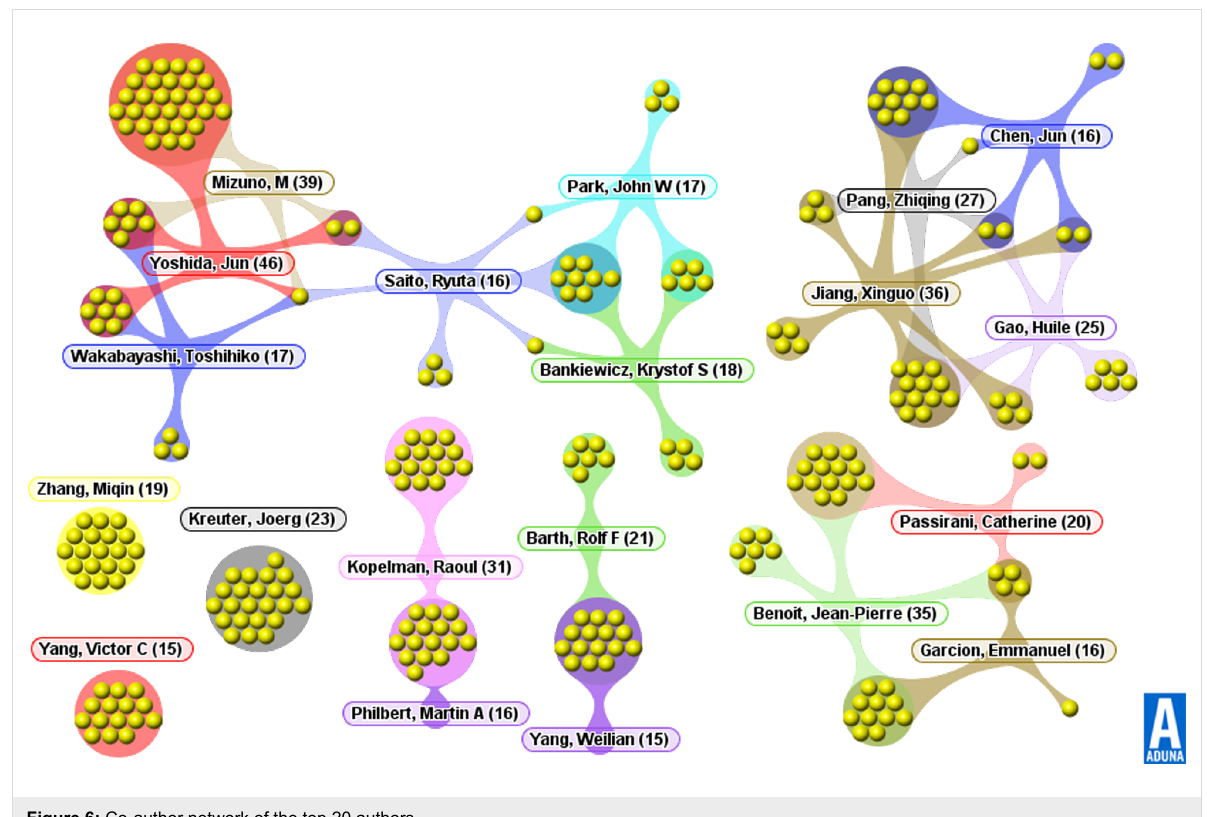
Figure 6: Co-author network of the top 20 authors.